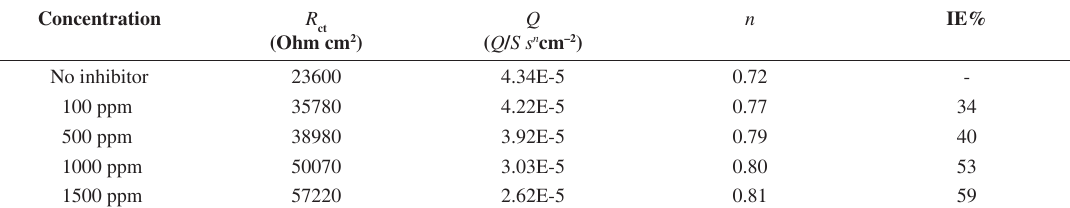
Table 4. EIS Data for Al-2007 alloy in 3.5% NaCl in the absence and presence of different concentration of mad honey. Concentration